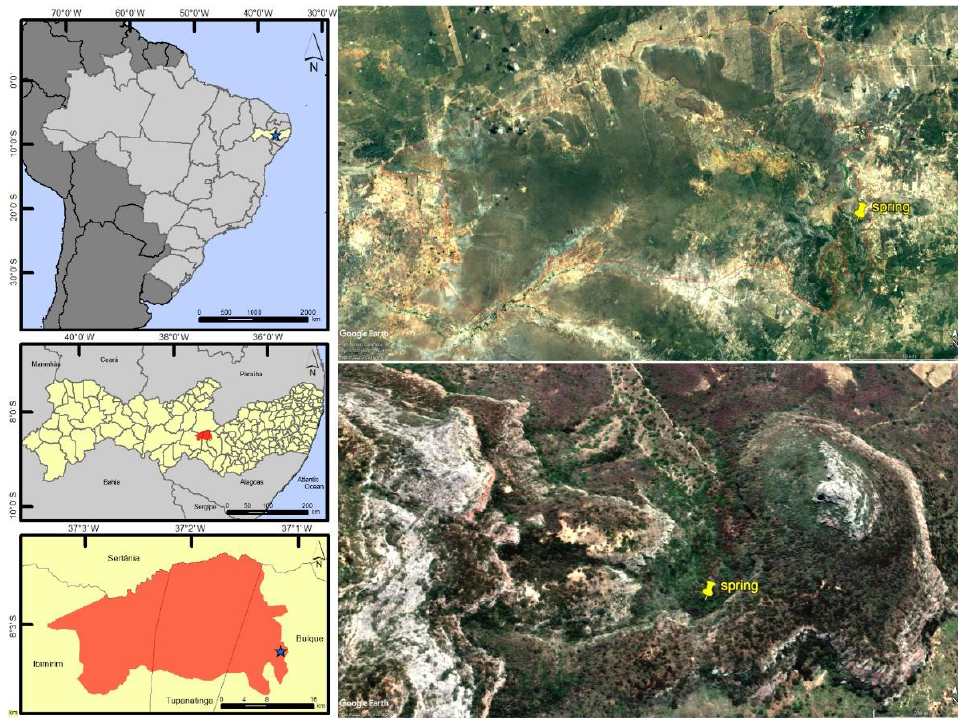
Figure 4. Geographic distribution of Paravelia luisi sp. nov. in the Catimbau National Park, Pernambuco state, Brazil. Right side images were produced using Google Earth.